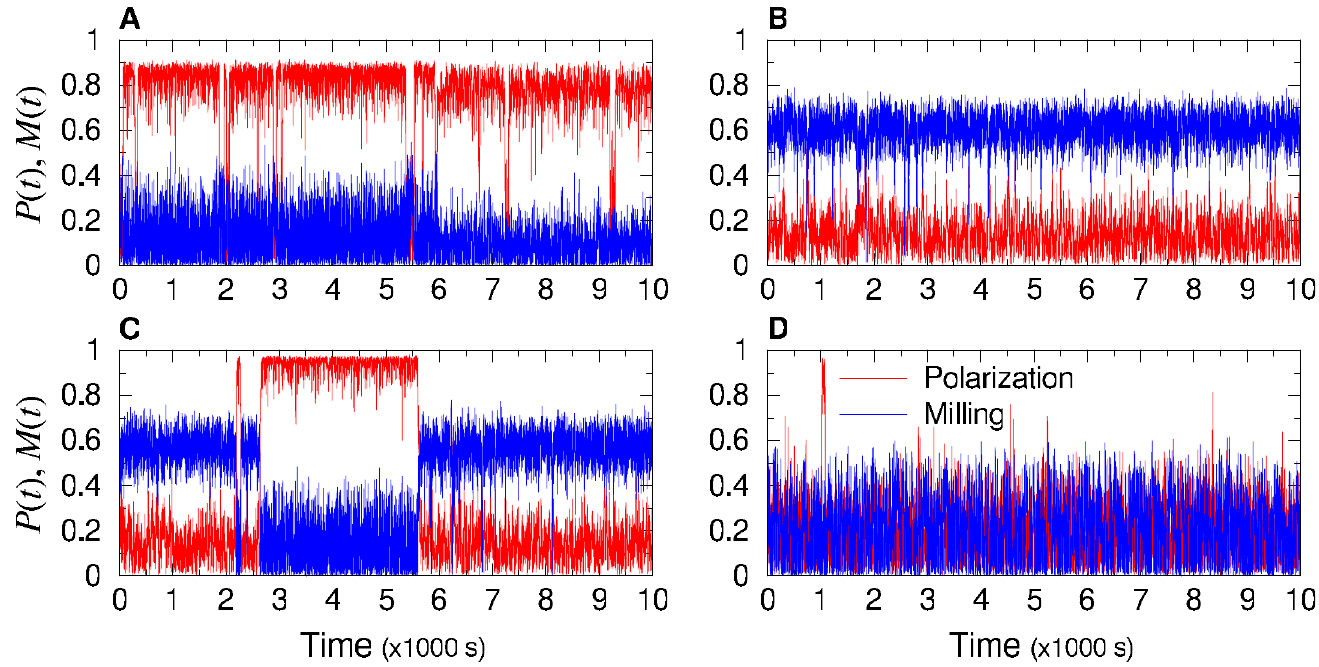
Fig 5. Time series of polarization (red line) and milling (blue line), representative of each characteristic collective state by a group of N = 100 fish when each fish only interacts with its most influential neighbor ( k = 1). (A) S CHOOLING state: ( γ Att , γ Ali ) = (0.04, 0.2), high polarization P ( t ) � 0.9, low milling M ( t ) � 0.22. (B) M ILLING state: ( γ Att , γ Ali ) = (0.05, 0.05), low polarization P ( t ) � 0.16, high milling M ( t ) � 0.6. (C) Intermittent state: ( γ Att , γ Ali ) = (0.033, 0.11), region where high polarization and high milling alternate: P ( t ) � 0.98 with M ( t ) � 0.22, and P ( t ) � 0.18 with M ( t ) � 0.6. (D) S WARMING state: ( γ Att , γ Ali ) = (0.06, 0.125), low values of both polarization and milling: P ( t ) � 0.2, M ( t ) � 0.2. Social interaction ranges are l Att = l Ali = 0.28 m, intensity of random fluctuation (noise) is γ R = 0.2. Time interval is [0, 10000] s, i.e ., more than 2.5